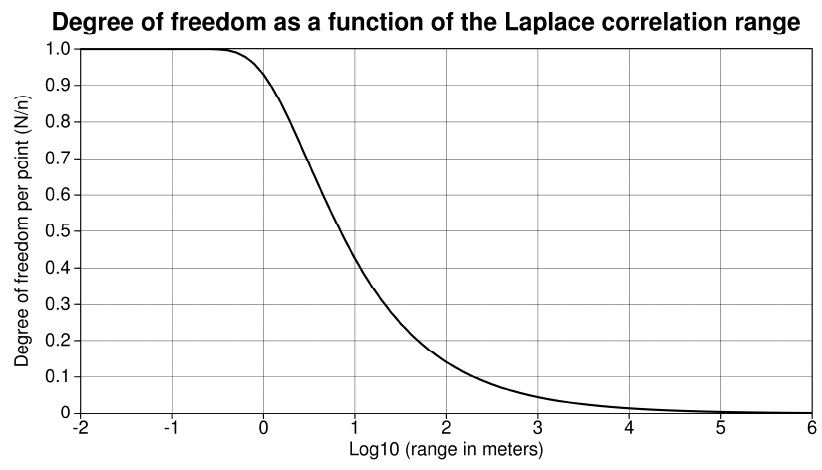
Figure 3. Degree of freedom per point (for a regular grid) as a function of the range (expressed in multiples of the grid step) of the correlation for a Laplace correlation function.